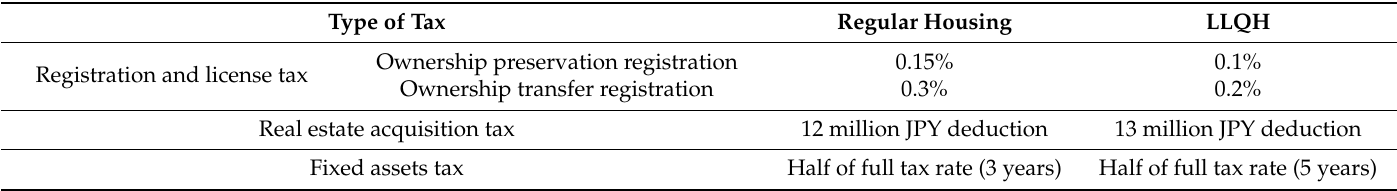
Table 1. Preferential measures for taxes for LLQH.